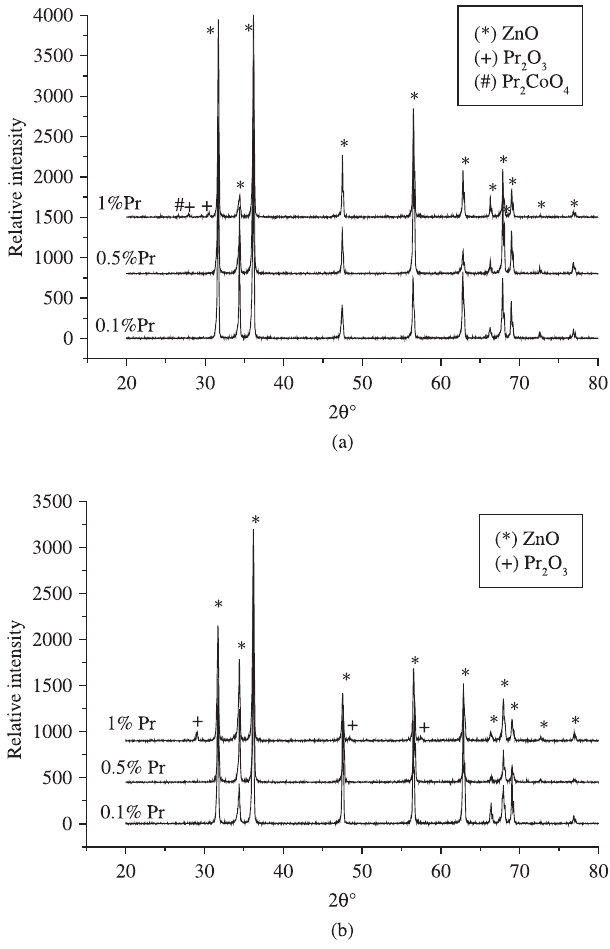
Figure 1. XRD patterns of ZPC with a different content of Pr indicating phases of samples sintered at a) 1300 °C and b) 1350